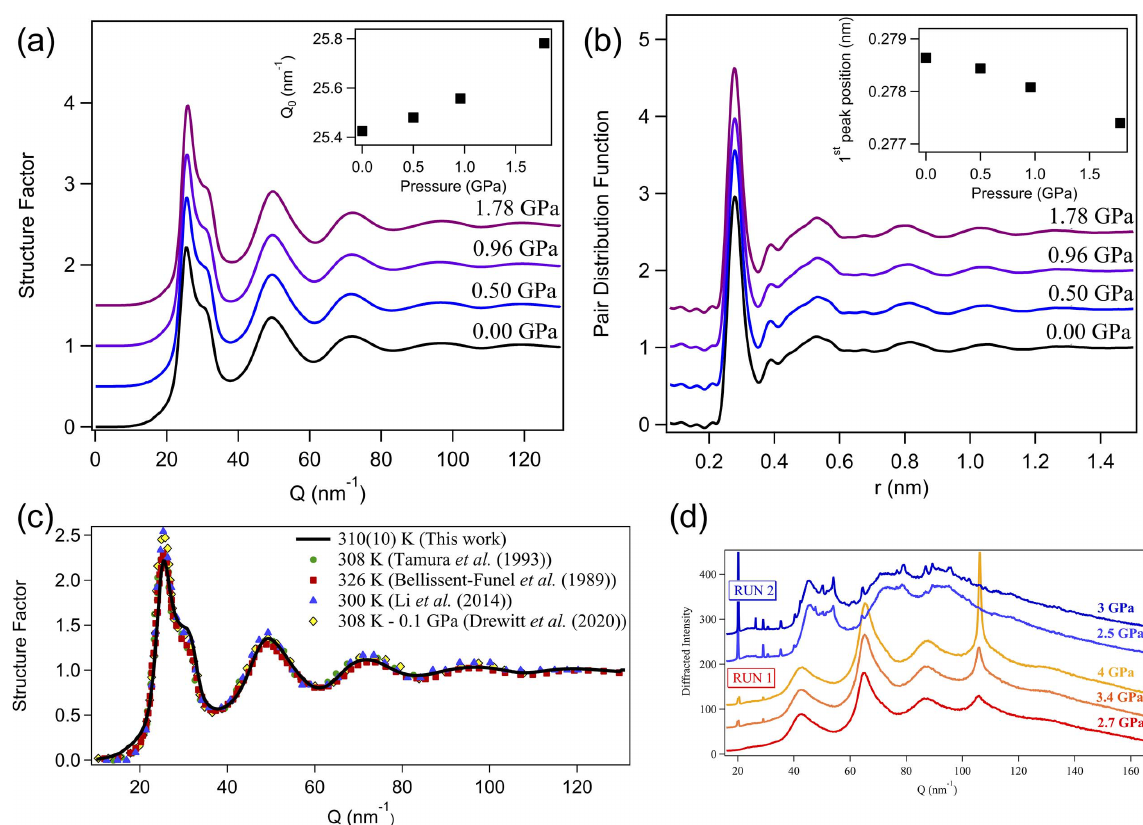
Figure 7 ( a , b ) Structure factor and corresponding pair distribution function of gallium in the stability region of the liquid along the pathway shown in Fig. 4( a ). For clarity, the structure factors and PDF have been offset vertically by 0.5. ( c ) Structure factor of liquid gallium at room pressure and 310 K from this work (solid black line) in comparison with previous studies (Tamura & Hosokawa, 1993; Bellissent-Funel et al. , 1989; Li et al. , 2017; Drewitt et al. , 2020). ( d ) Diffracted intensity of gallium in the stability region of Ga(II) at selected pressures from two different runs. The diffuse scattering observed is compatible with the formation of large crystals with different orientations between the two